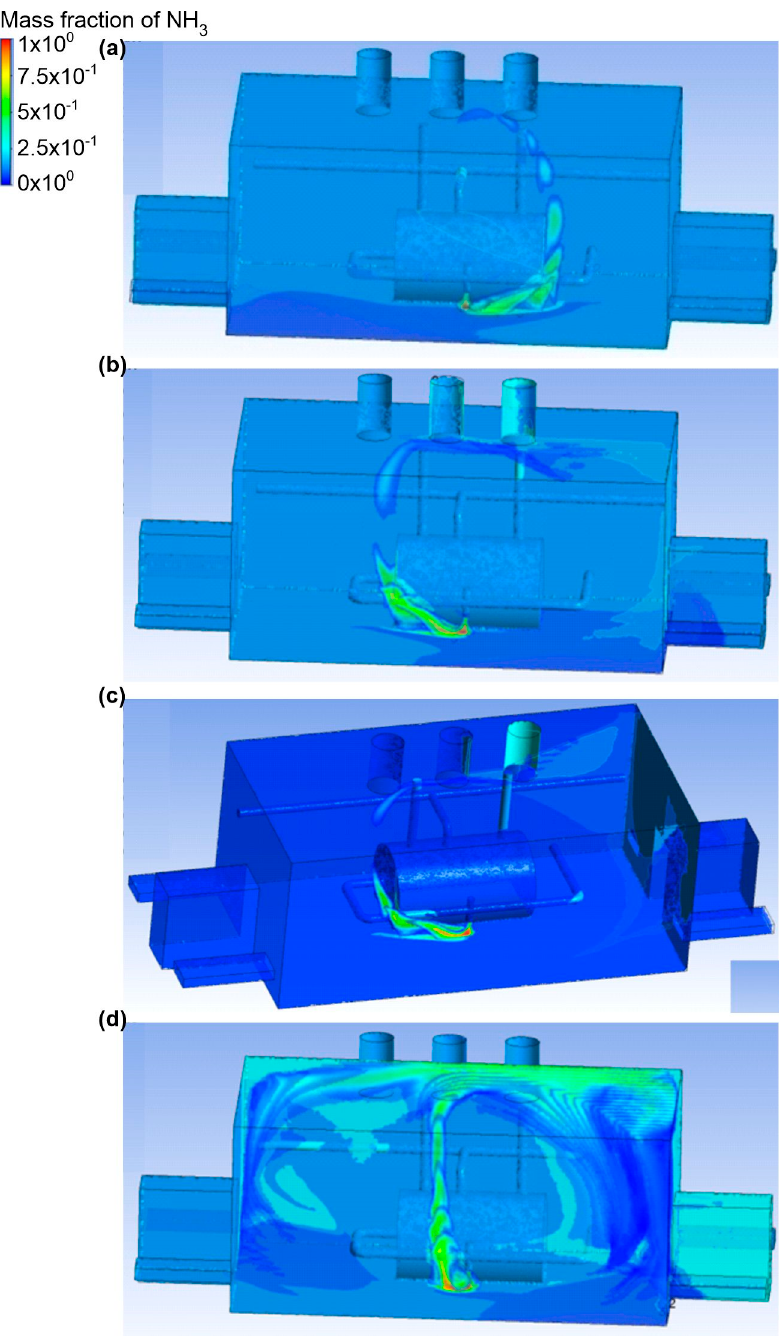
Figure 16. Ammonia distribution in the engine room for: ( a ) scenario A, ( b ) scenario B, ( c ) scenario C, and ( d ) scenario D.